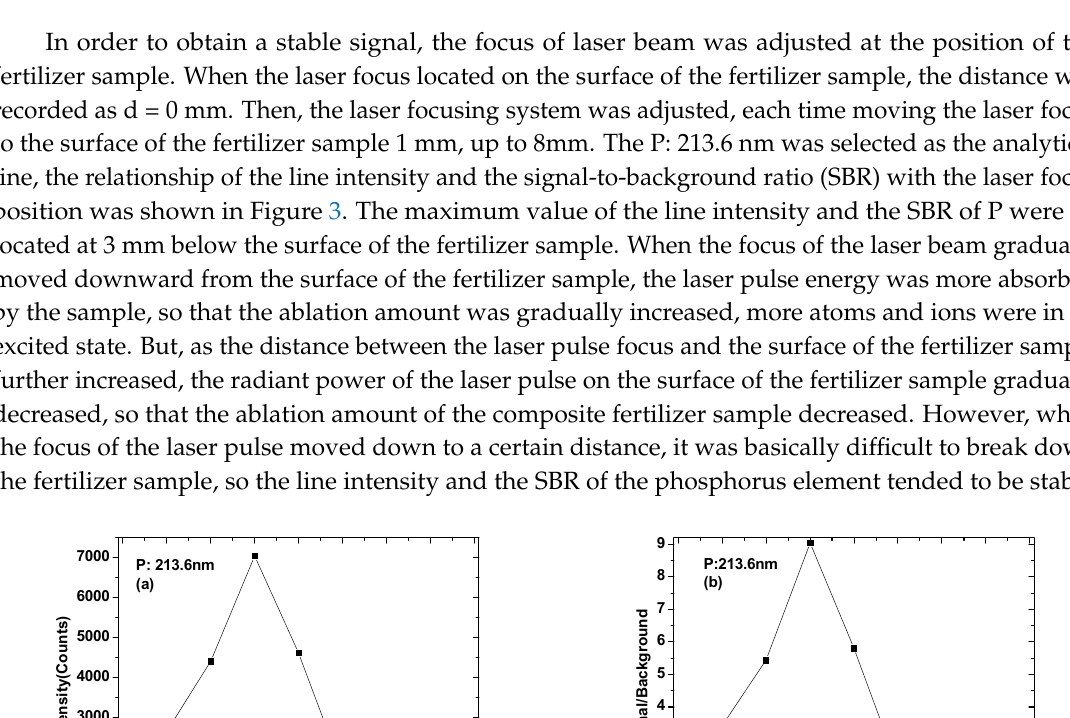
Figure 2. LIBS spectrum of compound fertilizer sample in the ranges of 210–222 and 252–258 nm (n = 20).